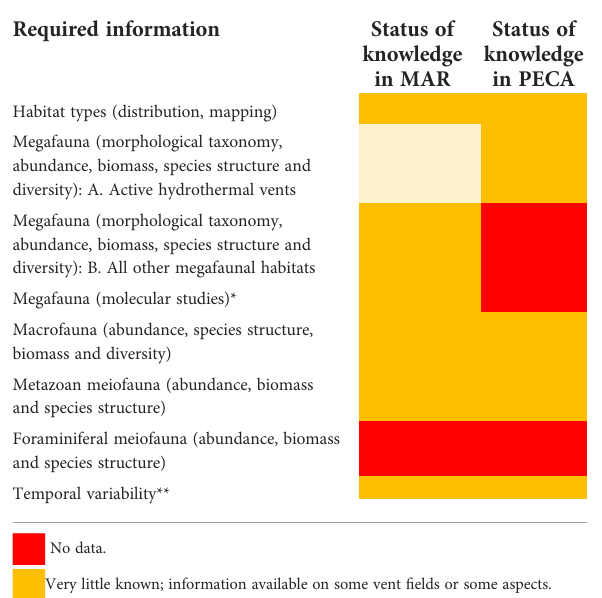
TABLE 4 Knowledge gaps in view of the ISA guidelines and recommendations (ISA, 2019). Required